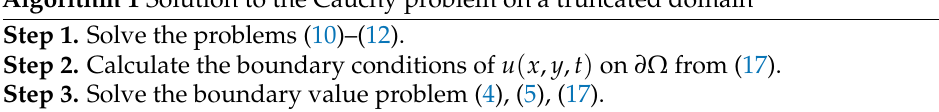
Algorithm 1 Solution to the Cauchy problem on a truncated